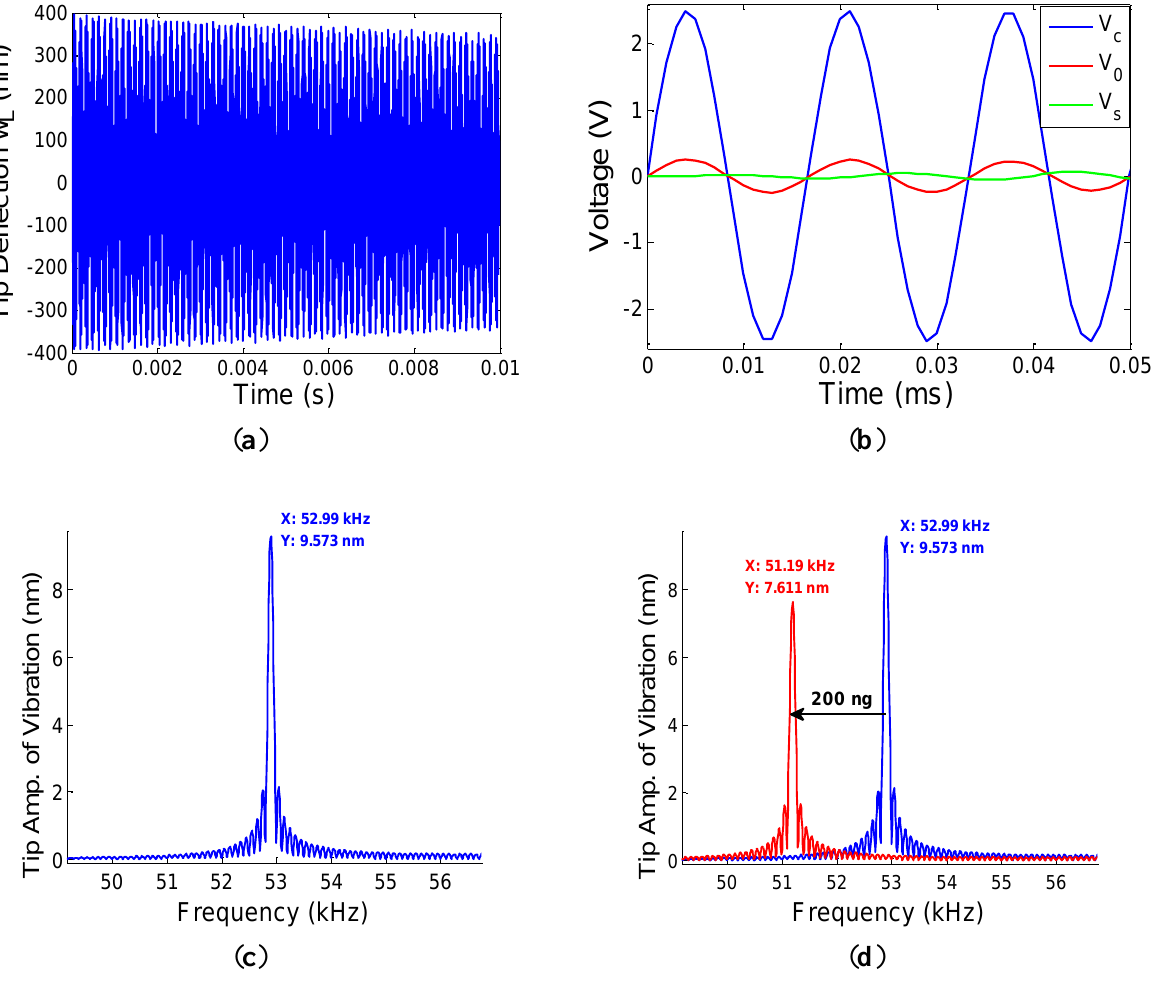
Figure 5. Sensitivity of the vibration amplitude of the tip of MC with respect to C